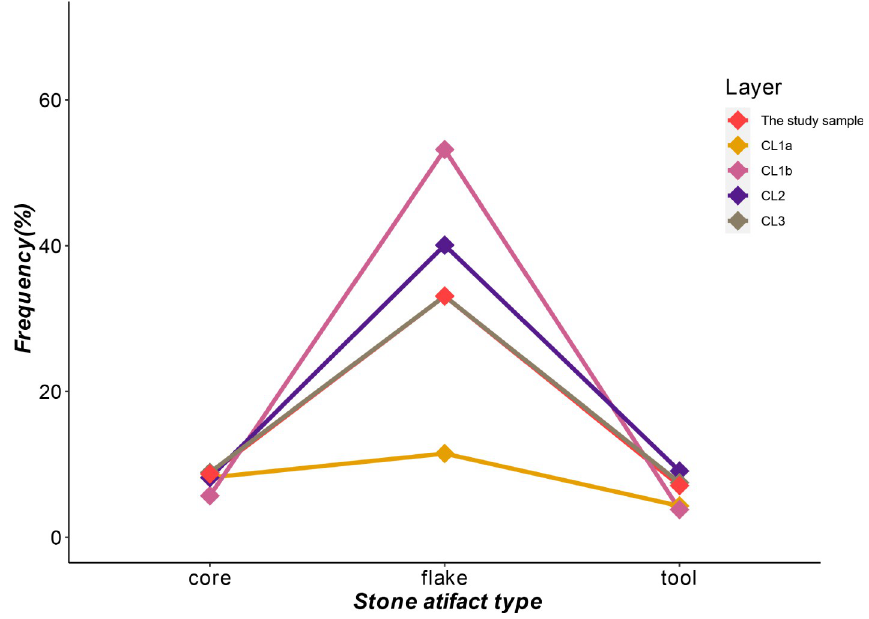
Fig 3. Frequencies of core, flake, and tool across